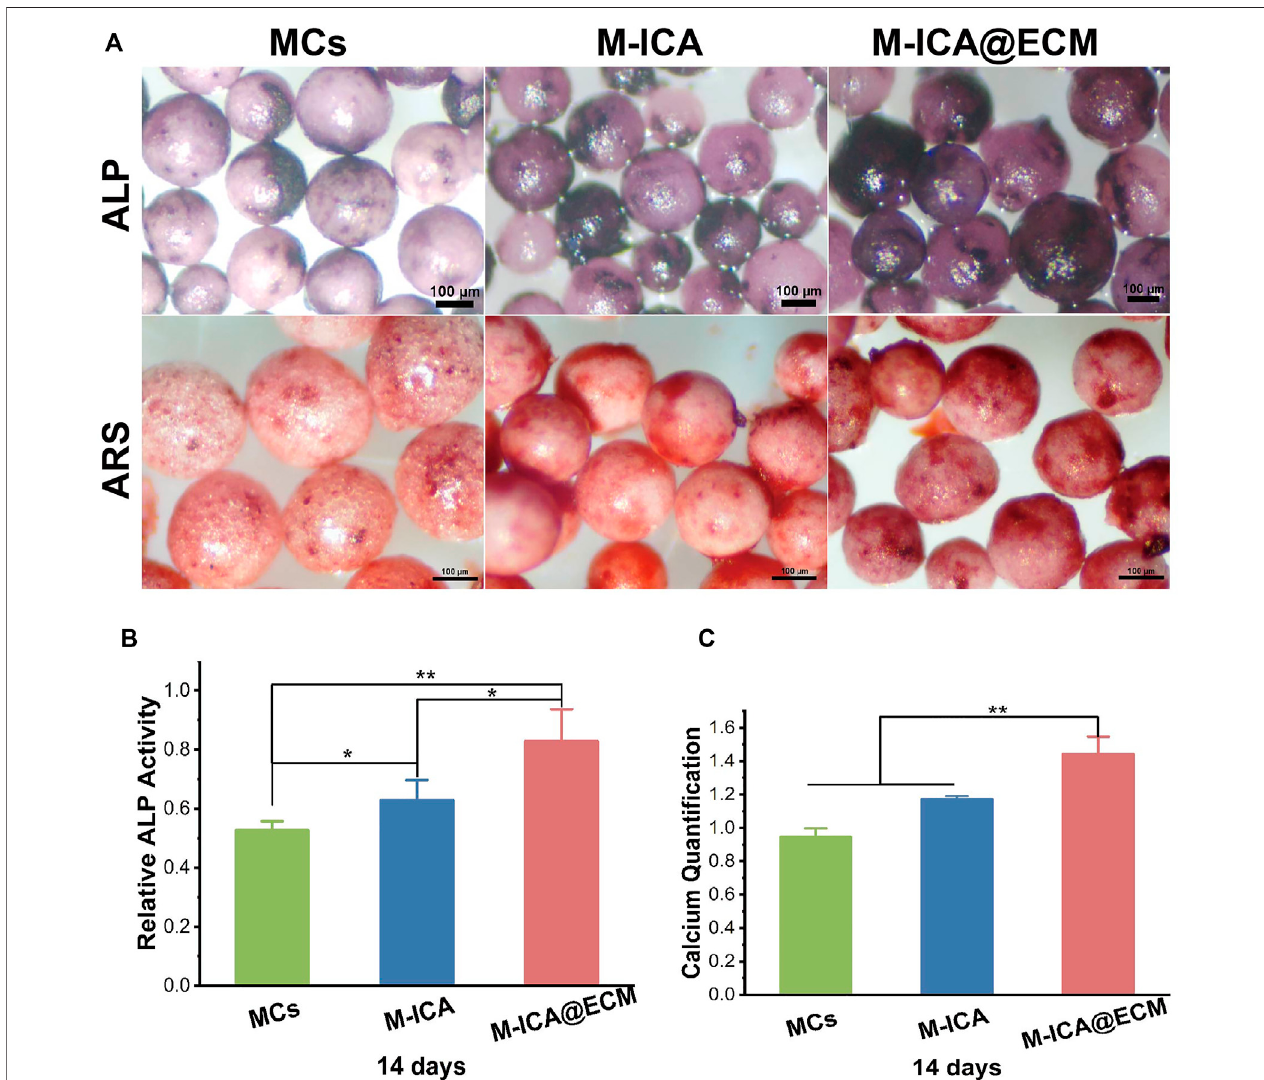
FIGURE 7 | (A) ALP and ARS staining after incubation for 14 days on MCs, M-ICA, M-ICA@ECM (Scale bar = 100 μ m). The corresponding ALP quantitative evaluation analysis (B) and corresponding calcium deposition quantitation (C) after cultured on MCs, M-ICA, M-ICA@ECM for 14 days. (* p < 0.05, ** p < 0.01, n =